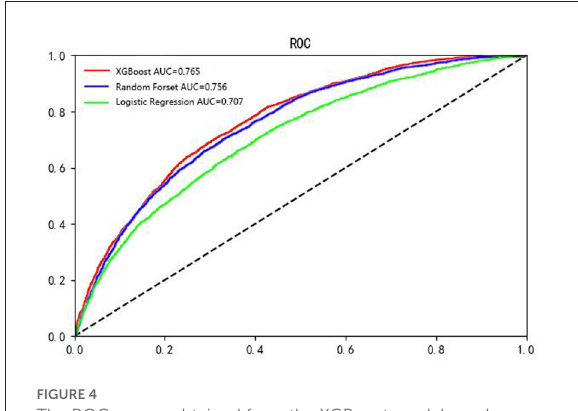
FIGURE4 The ROC curves obtained from the XGBoost model, random forest model and logistic regression model. X axis: 1-specificity, Y axis: sensitivity. The reference line is shown as a dashed line (the black line).